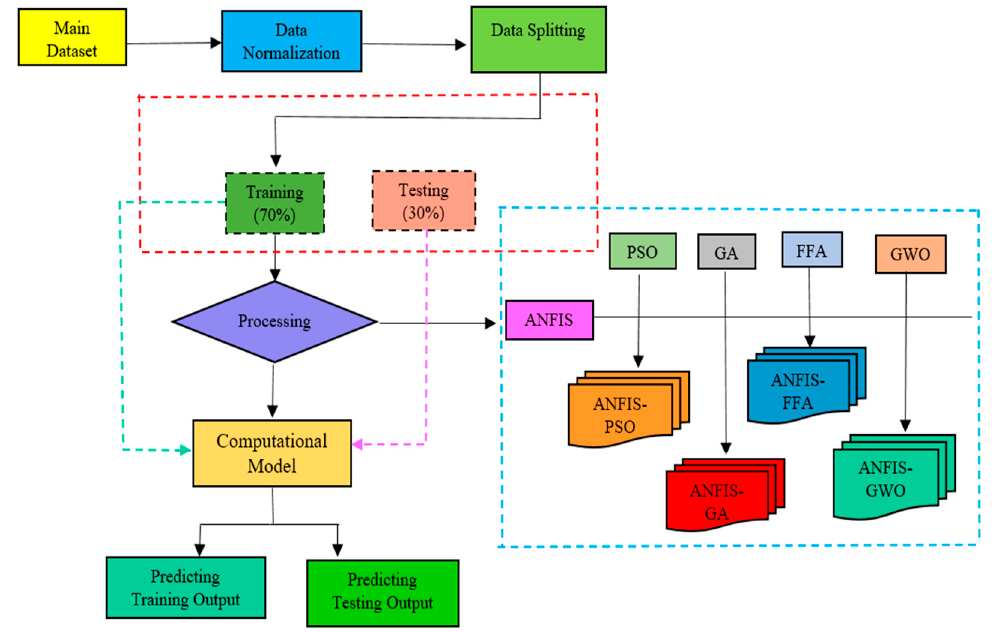
Figure 5. Methodology flowchart.